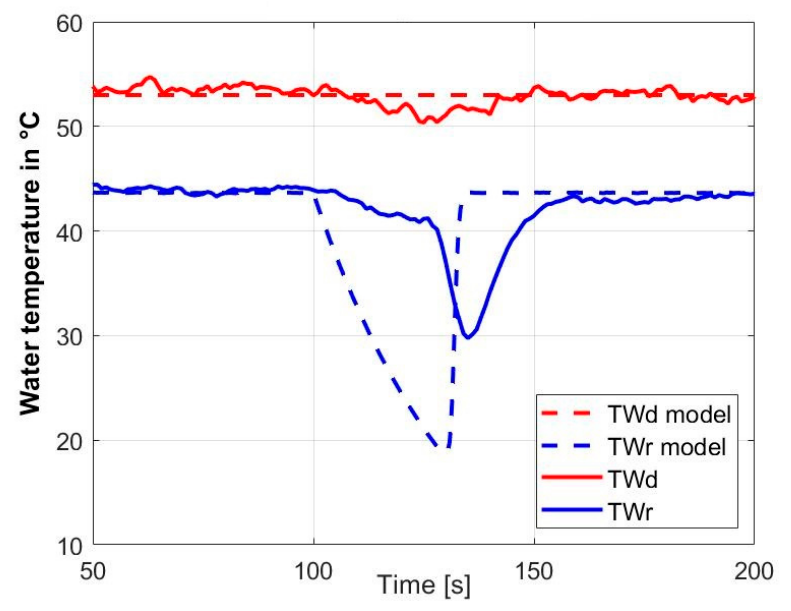
Figure 18. Diagram of comparison between model and experimental data for a number of sections n = 20 for water temperatures.